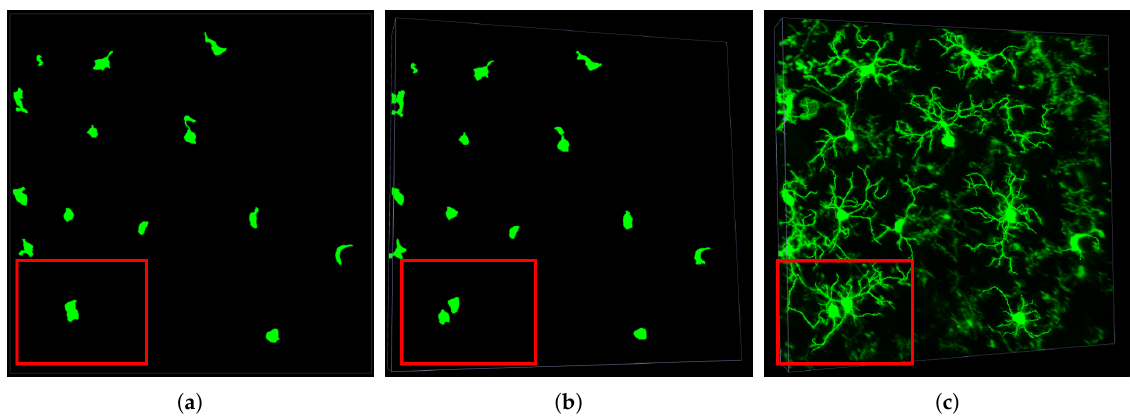
Figure 4. Soma detection: ( a ) 2D view, ( b ) 3D view, and ( c ) 3D tracing of each cell. The red box in the images indicate the region of interest where soma overlap and would be difficult to distinguish in the top 2D projection of the 3D